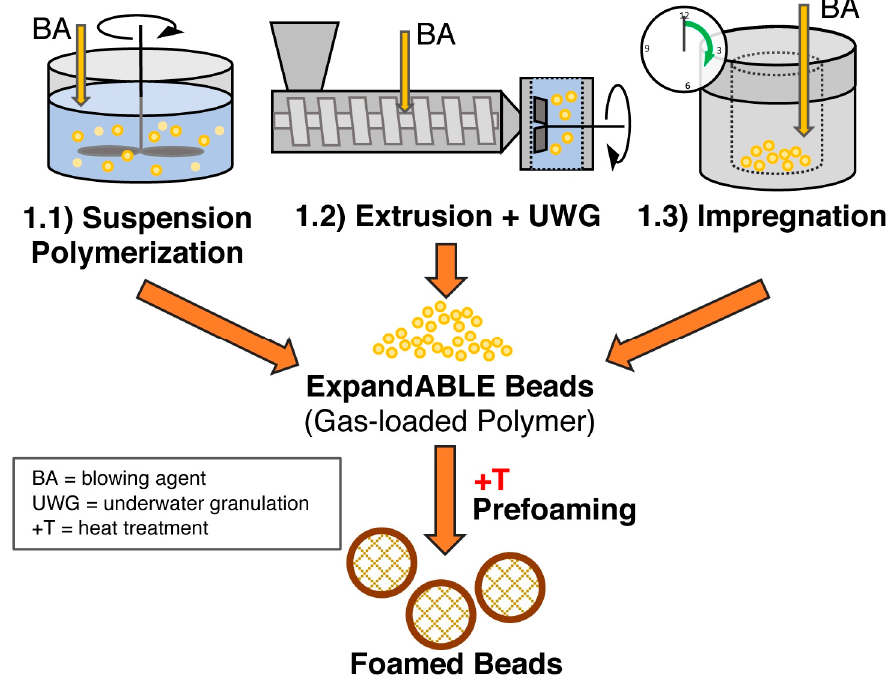
Figure 8. Overview of different methods to produce expandable bead foams.